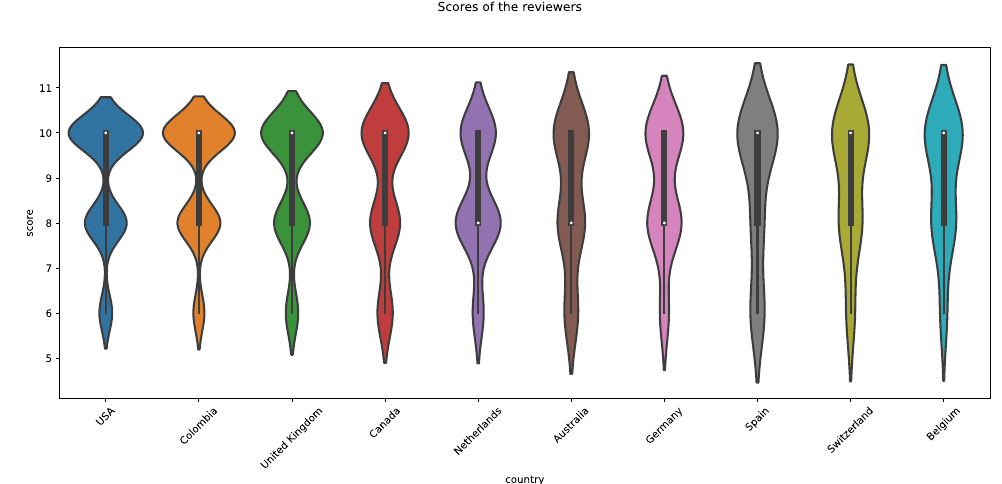
Figure 8. Distribution of the scores of the top 10 nationalities of reviewers of Colombia’s tourist reviews dataset obtained from OntoTouTra (language: English).